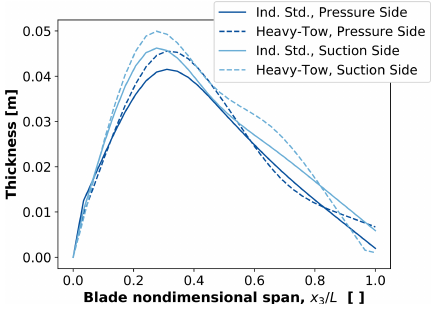
Figure 15. Comparison of optimized spar cap thickness distribu- tion for the BAR-USC design using industry-standard carbon fiber unidirectional composite and heavy-tow fiber composite.